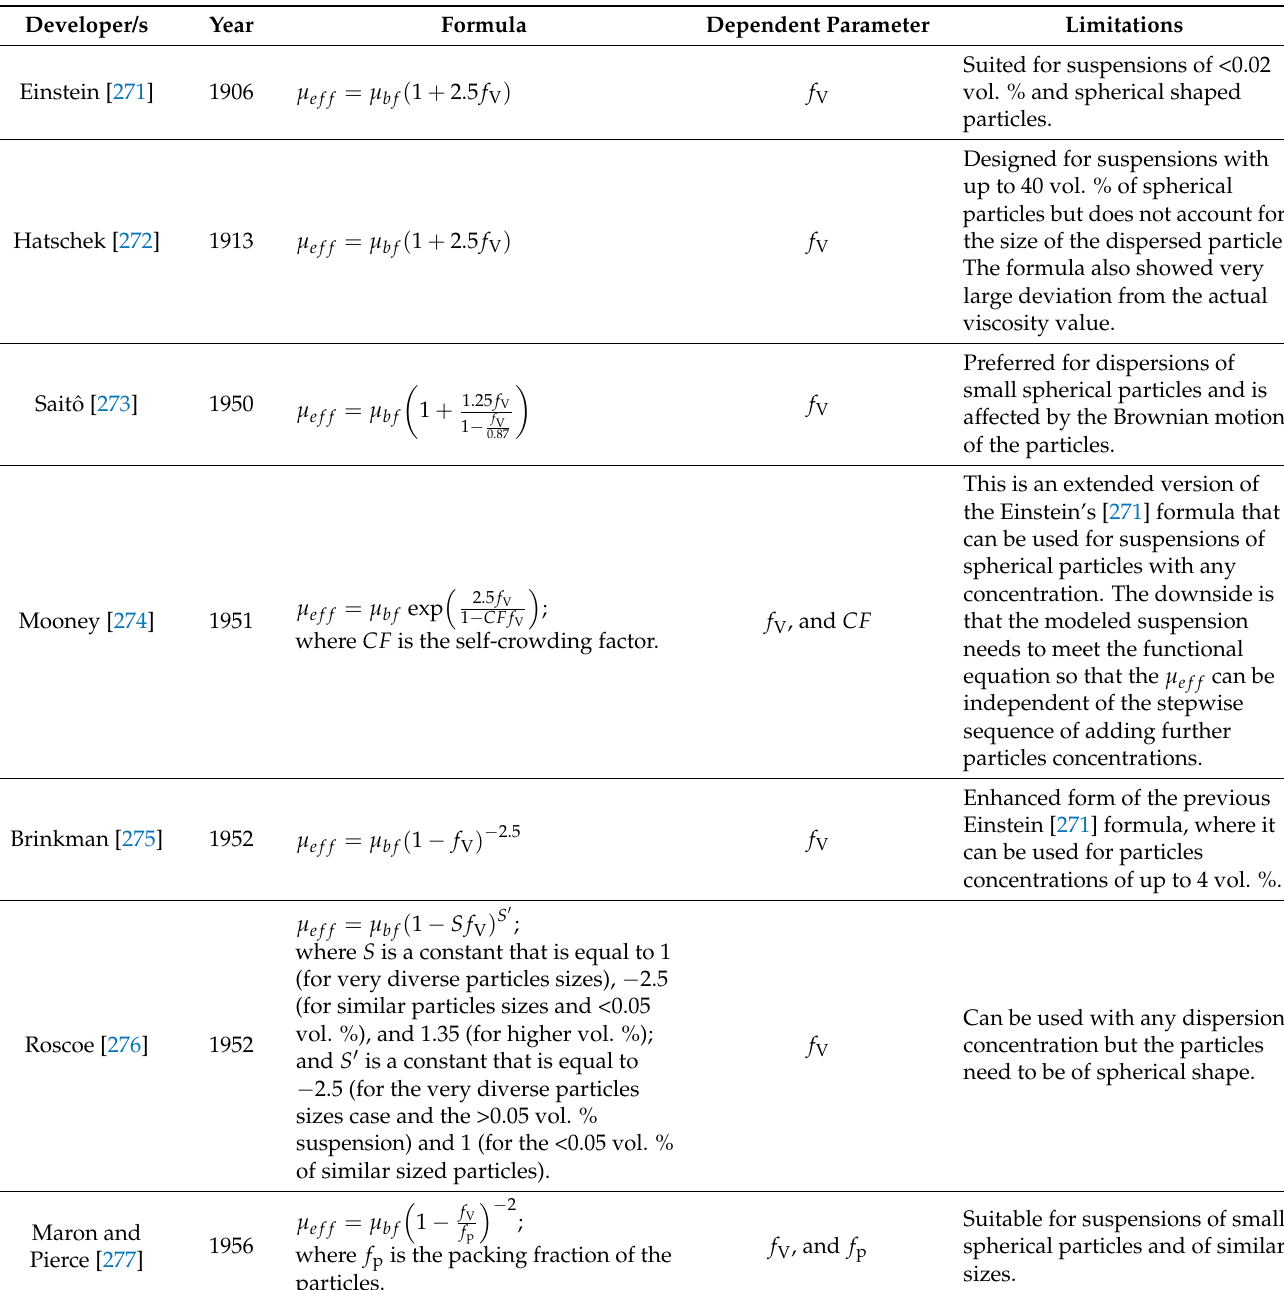
Table 5. Developments of nanofluids effective viscosity